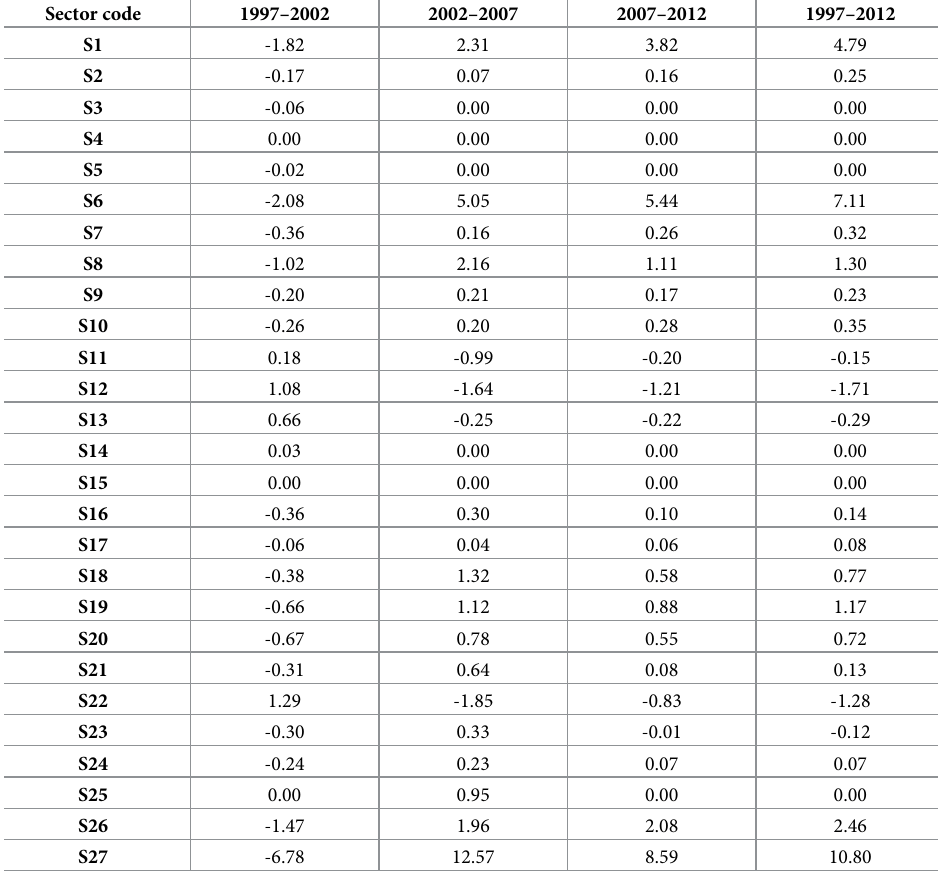
Table 5. Comparison of between-group consumption substitution effects: Contribution to household indirect sec- toral energy consumption change (unit: